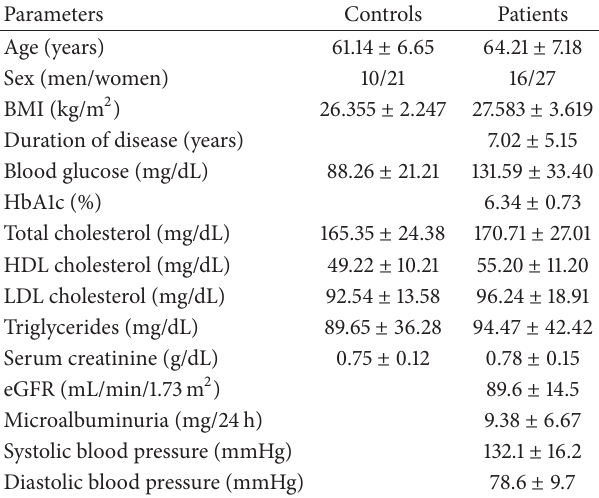
Table 1: Demographic and clinical characteristics of both patients and